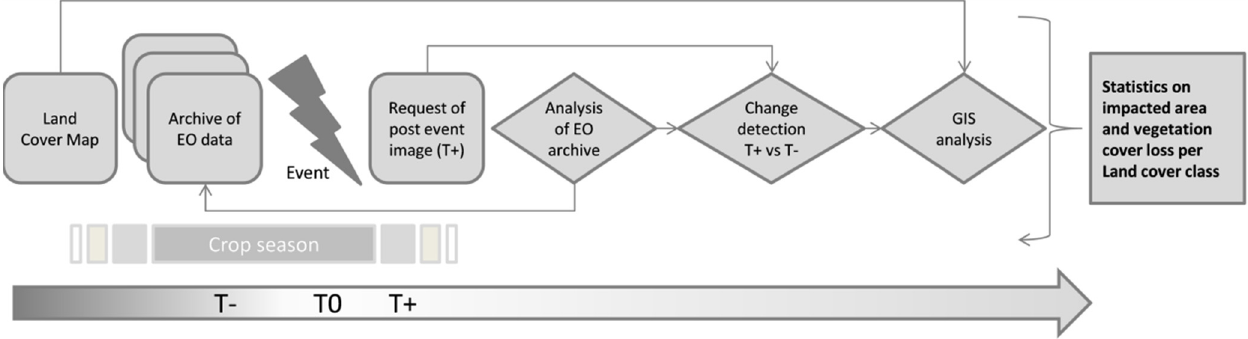
Figure 2. The timeline of post-event remote sensing